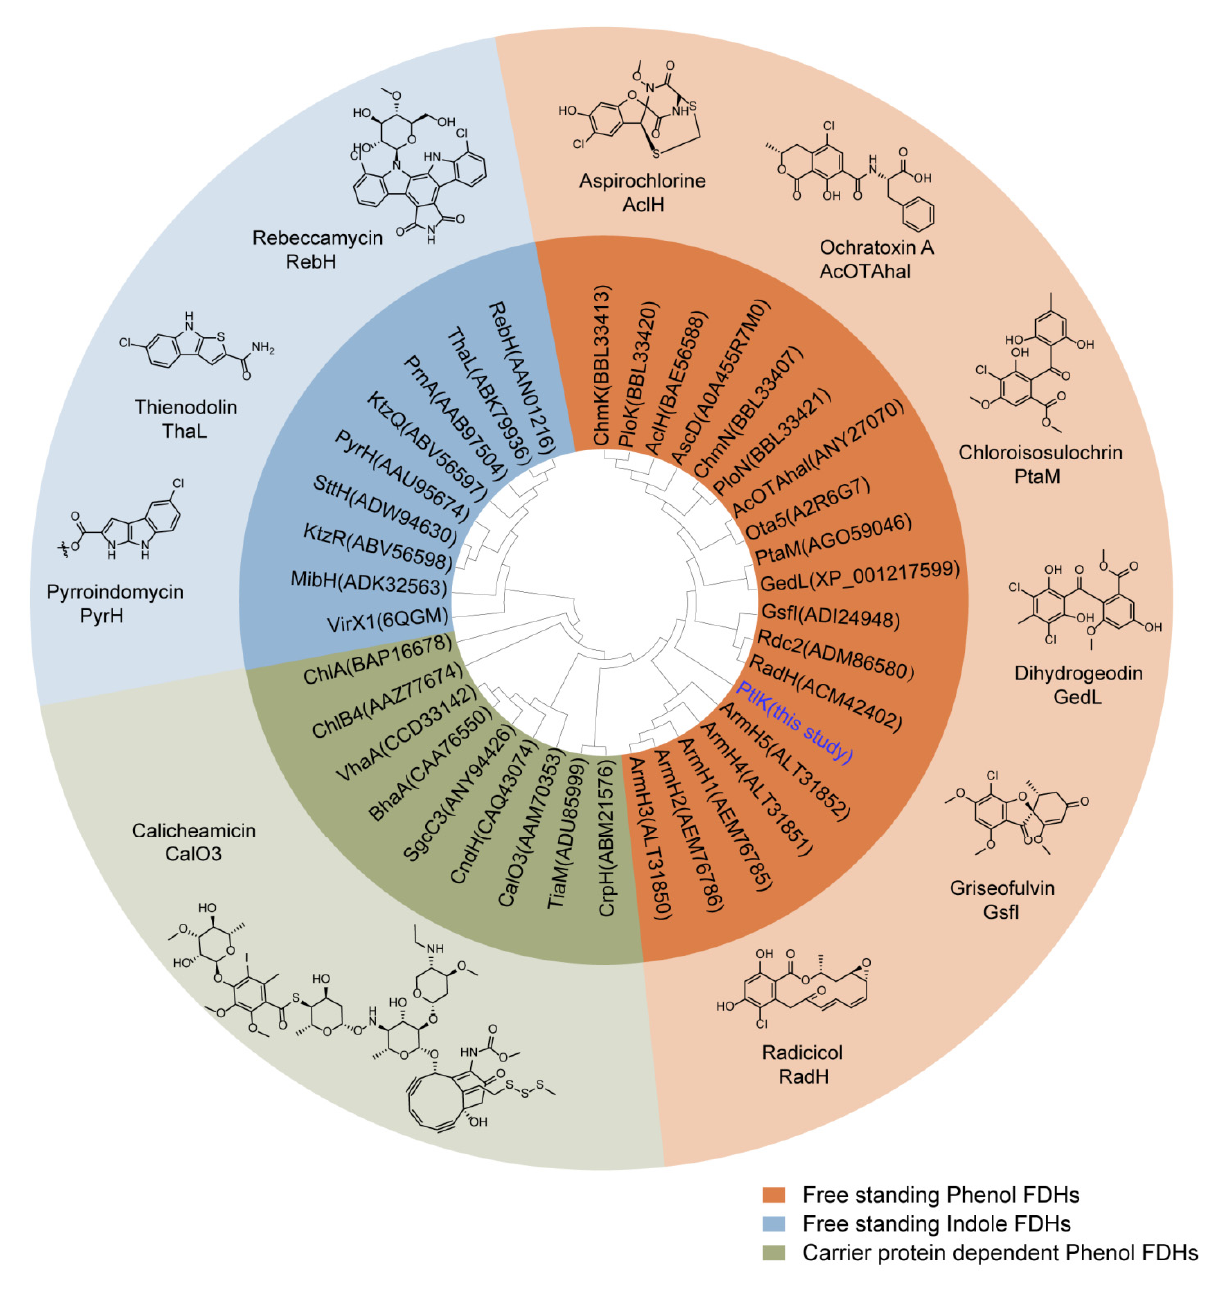
Figure 2. Phylogenetic tree based on amino acid sequences of PtlK and the selected flavin-dependent halogenases (FDHs). GenBank, UniProtKB, or PDB accession numbers are given in parentheses. The three dominant categories of FDHs: free-standing phenol, free-standing indole, and carrier protein-dependent phenol FDHs are highlighted in orange, blue, and green, respectively. Representative products are shown beside. The phylogenetic tree was constructed using the UPGMA method. Visualization was conducted with MEGA7.